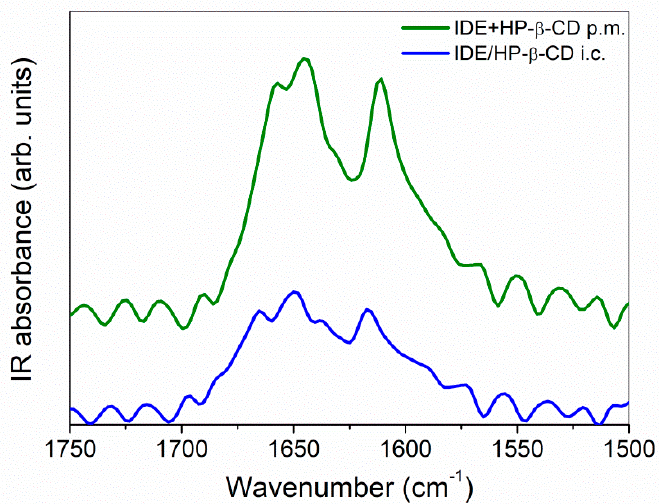
Figure 7. FTIR-ATR spectra, in the 1750 − 1500 cm − 1 mid-infrared spectral range, for the IDE + HP- β -CD physical mixture (p.m., green line) and IDE/HP- β -CD inclusion complex (i.c., blue line), at T = 300 K as an example.